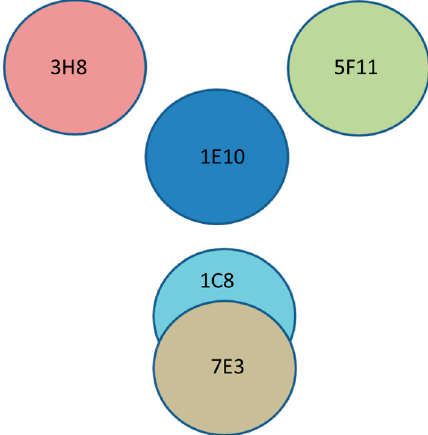
Figure 4. A diagram of conformational epitopes of flagellin centered by the epitope of MAb 1E10. Four distinct epitopes were identified using five anti-flagellin antibodies (MAb 3H8, MAb 5F11, MAb 1C8, MAb 7E3, and MAb 1E10). Overlapping circles denote common epitopes shared by MAb 1C8 and MAb